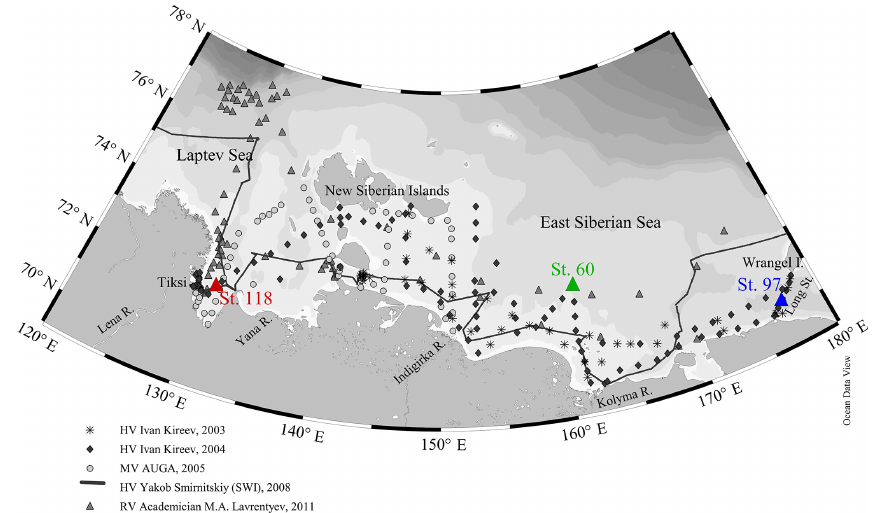
Figure 1. Study area: location of oceanographic stations at which measurements were taken in August–October 2003, 2004, 2005, 2008, and 2011. Location of selected stations on the ESAS in September 2004 is shown in